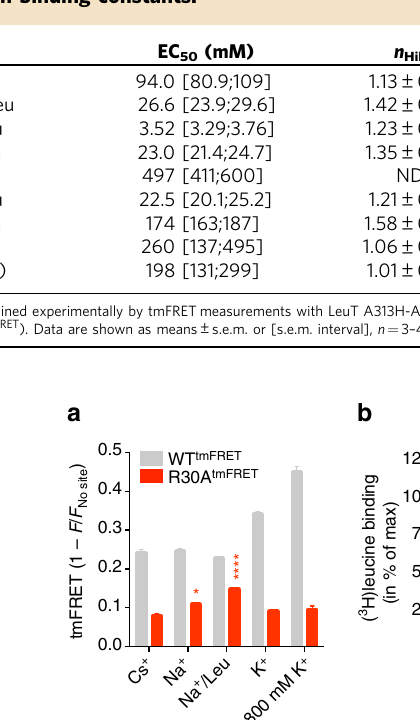
Table 1 | Ion binding constants.